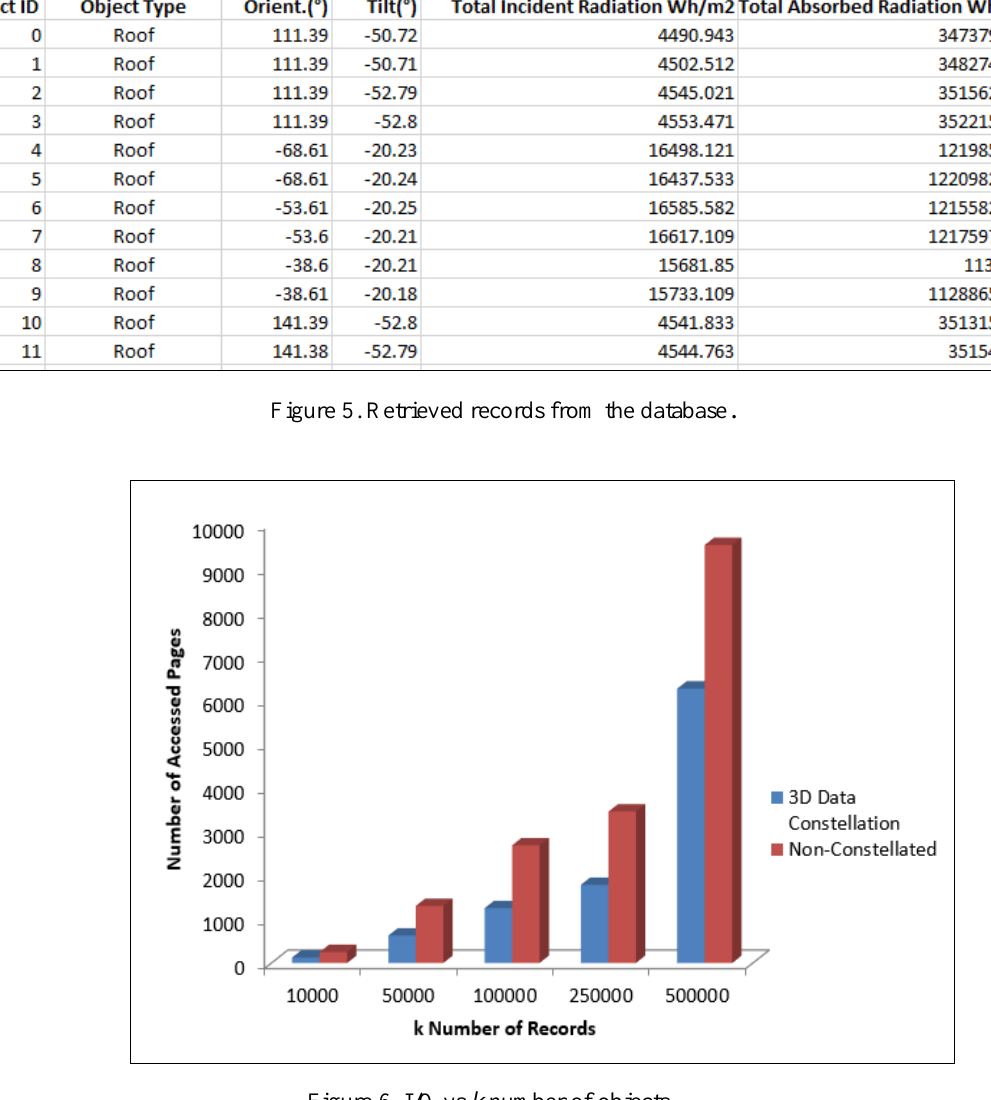
Figure 6. I/O vs k number of objects.